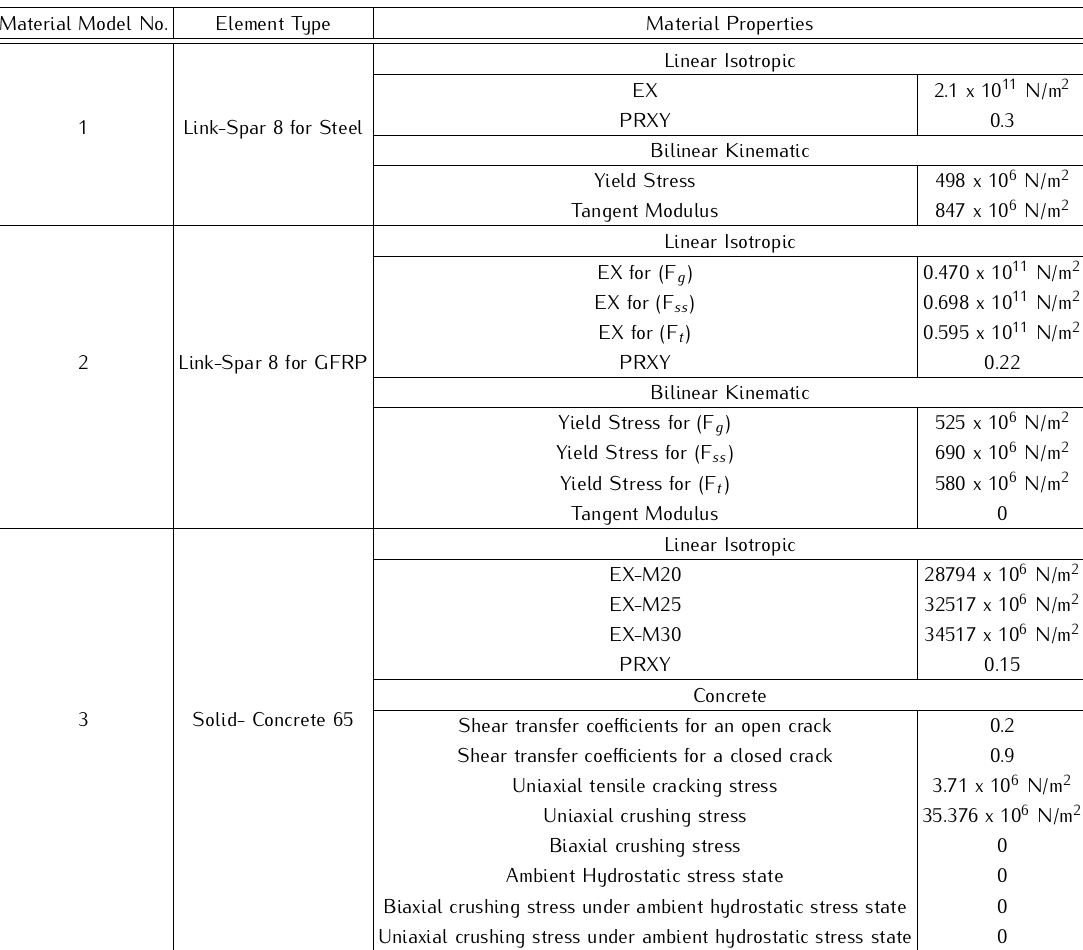
Table 6. Material